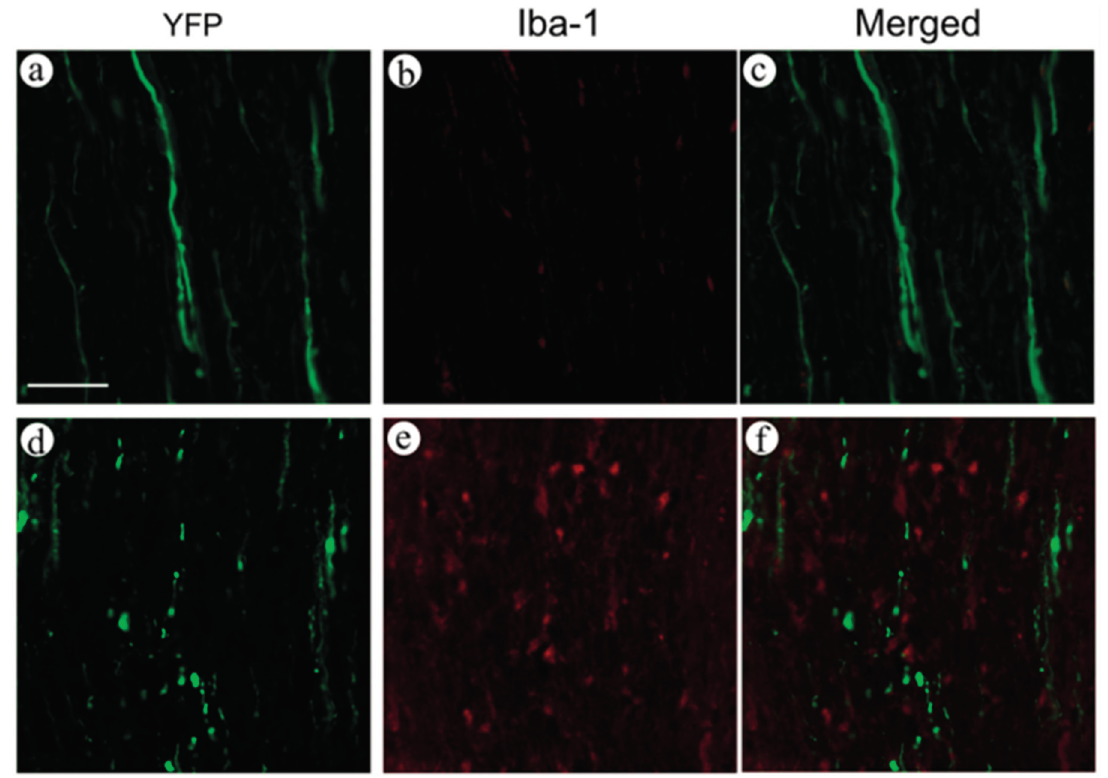
Figure 5. Double staining of YFP and Iba-1, a marker of microglia and macrophages, in the spinal cord of both normal ( a – c ) and contusion injury mice ( d – f ) seven days after treatment. YFP was labeled with FITC ( a , d ). Iba-1 was labeled with Cy3 ( b , e ). Merged images are shown in c and f . Scale bar is 50 μ